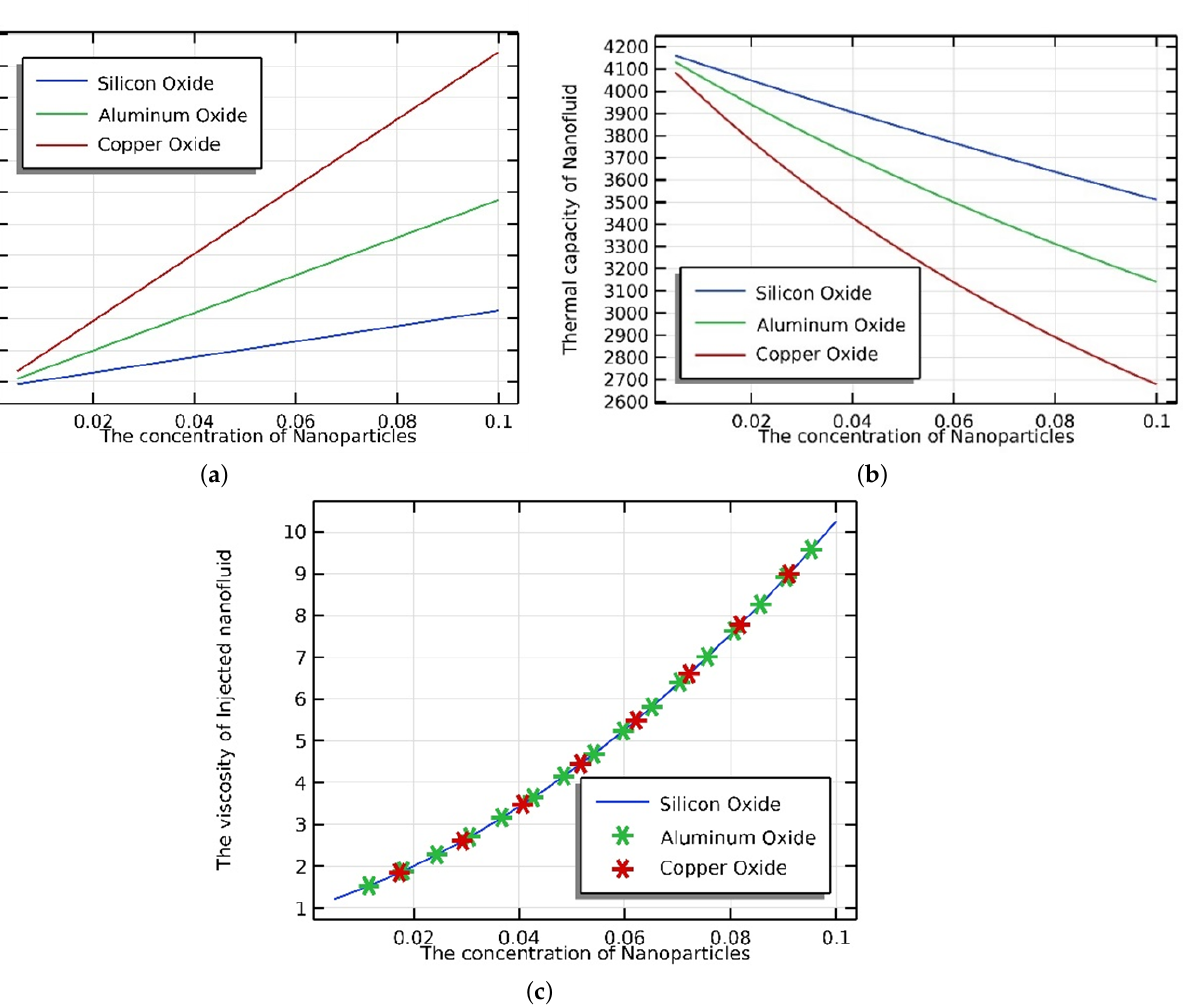
Figure 6. ( a ) The effect of NP volume fraction on density, ( b ) on thermal capacity, and ( c ) on